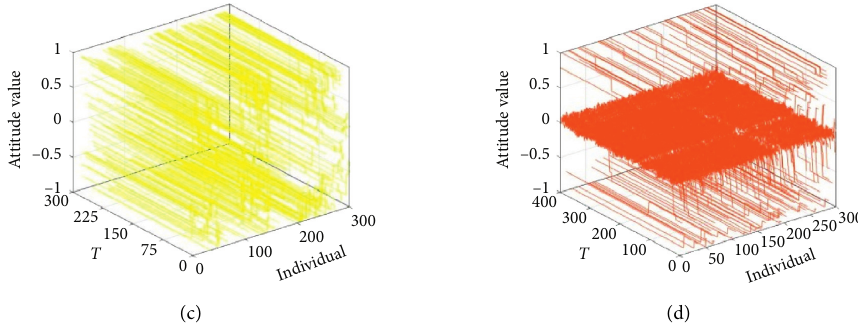
Figure 20: Comparison of attitude polarization process under different network structures ( p � 0 . 01). Polarization trend charts of (a) participants under different network structures, (b) participants under BA network, (c) participants under SW network, and (d) participants under FCN network.